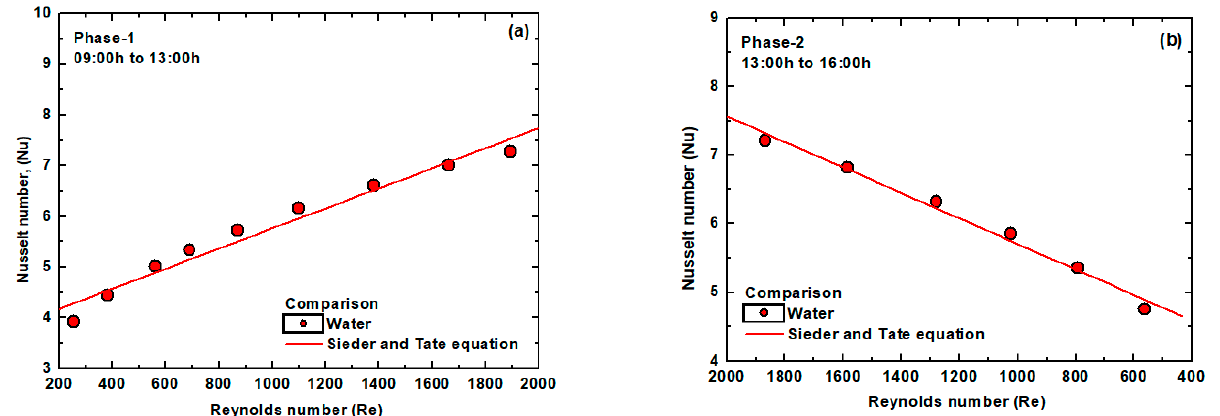
Figure 10. The Nusselt number validation with literature data; Phase-1 ( a ) and Phase-2 ( b ).